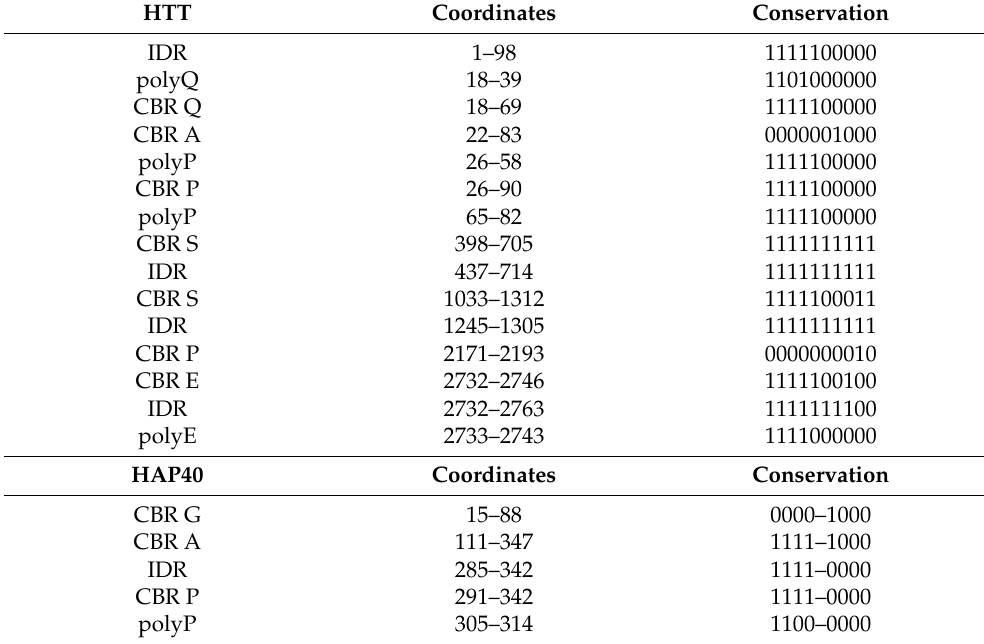
Table 3. LCRs detected in HTT and HAP40. Columns indicate feature type, coordinates in alignment, and conservation in 10 orthologs (as a binary pattern, see Methods for